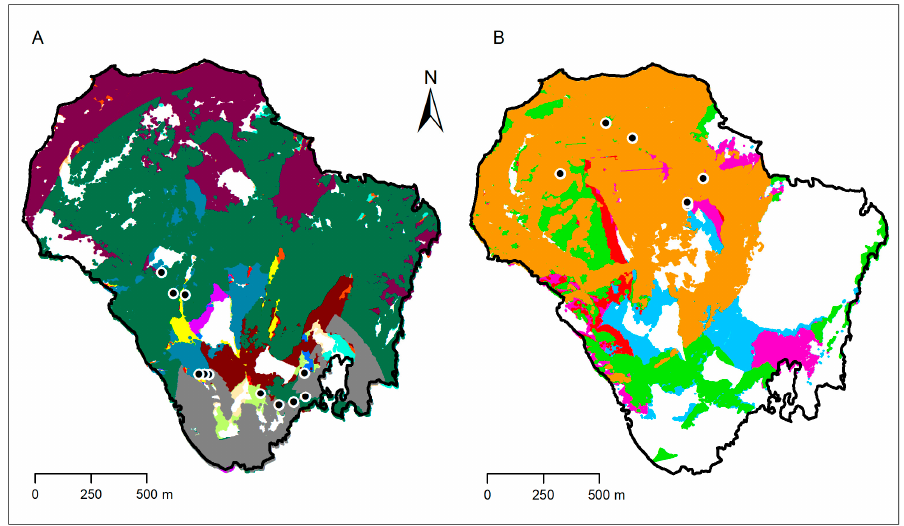
Figure 5. TLS data coverage per each scanner position during ( A ) the September campaign and ( B ) the October campaign. Black dots show location of the scanner positions.